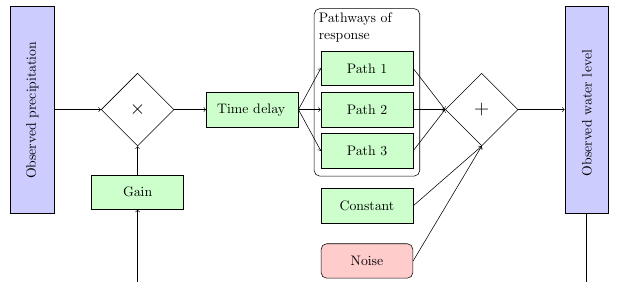
Figure 4. Schematic representation of a simplified DBM model showing the relationship between input precipitation, gain, linear pathways of response, a constant minimum water level and noise that gives the observed water